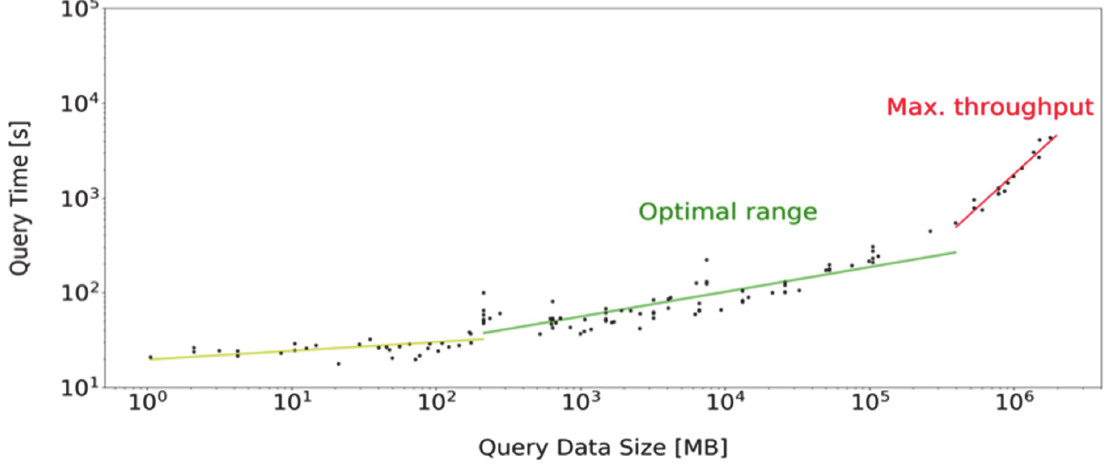
Figure 6: Query time versus query data size on PAIRS Geoscope, showing the increase from latency at low data size to a plateau of relatively constant query time for a wide range of data sizes in the scalable regime. Query time increases for larger data sizes when each storage node requires more than full utilization. The scalable range can be increased by adding more